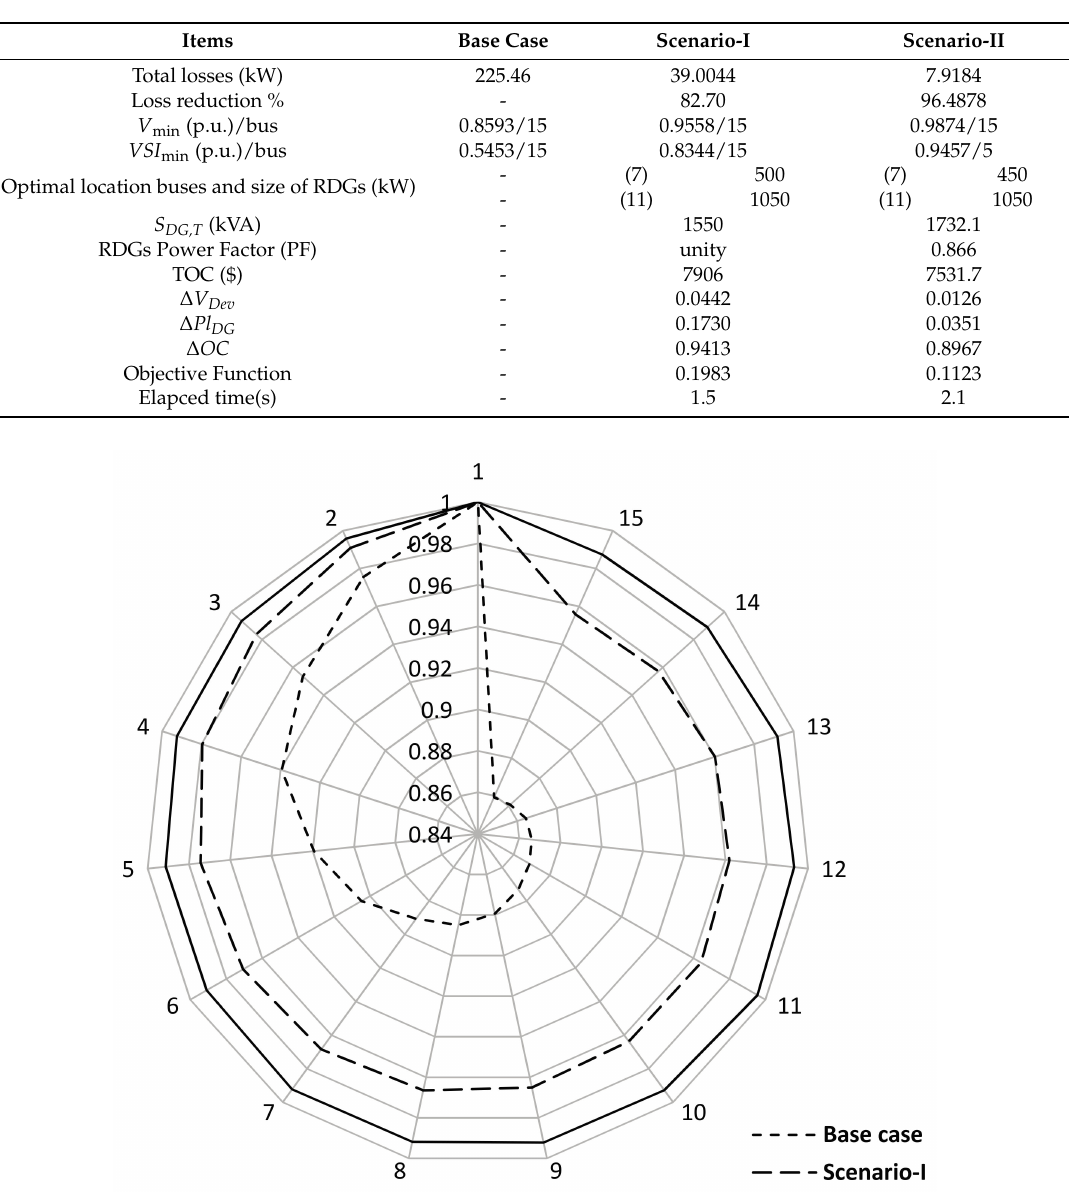
Table 10. The results of 15-bus of MEDN with PV and/or WT systems at maximum peak load (14:00 h).